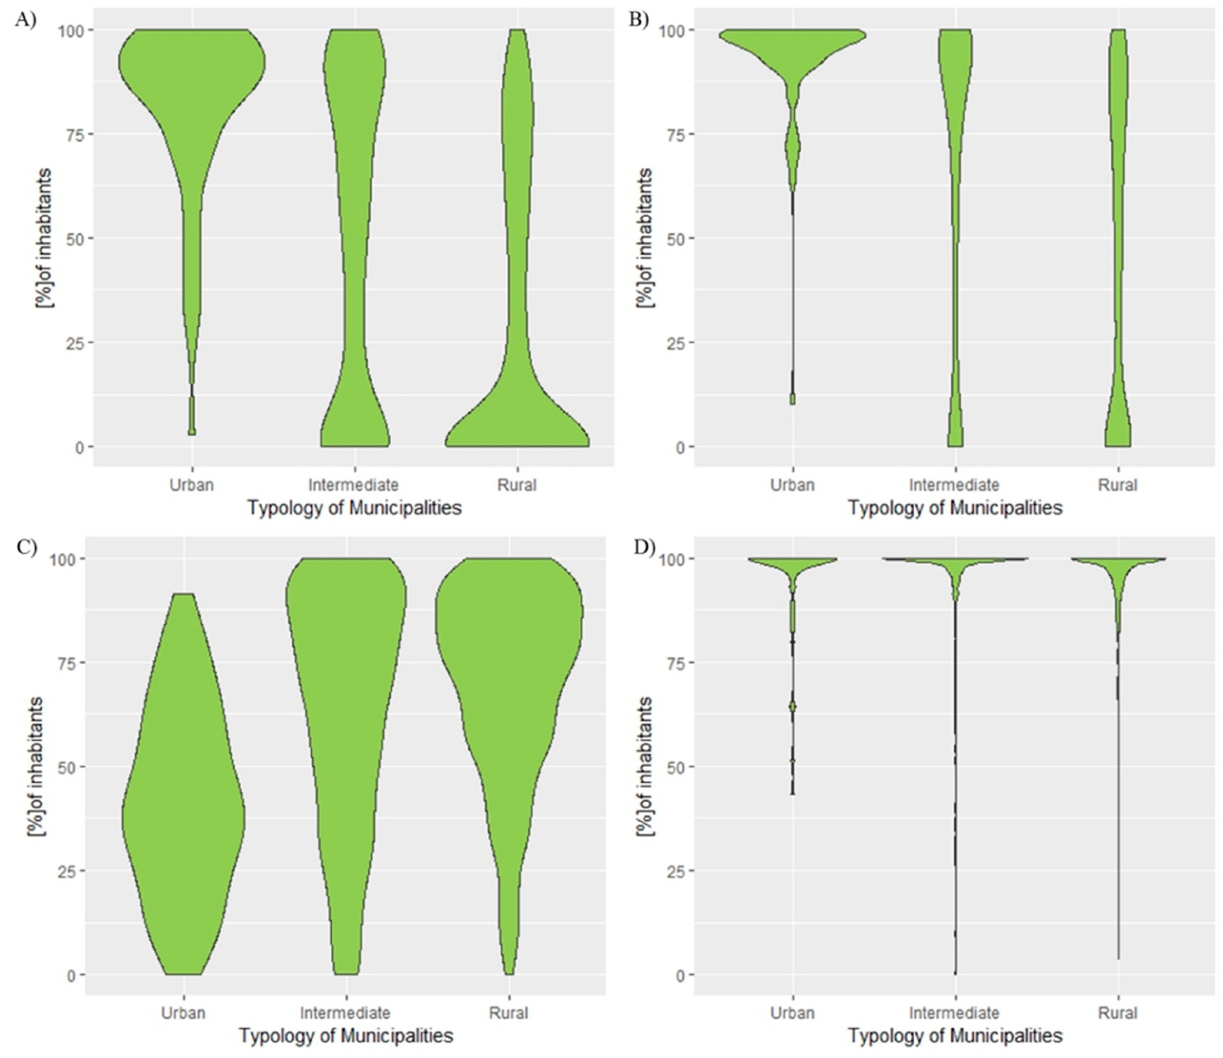
Figure 6. Percentage of the population with access to a UGS within ( A ) 10 min and ( B ) 15 min, according to the urban typology of the municipalities. Percentage of the population with access to a forest within ( C ) 5 min and ( D ) 15 min. Model’s specifications are the same as in Figure 5.